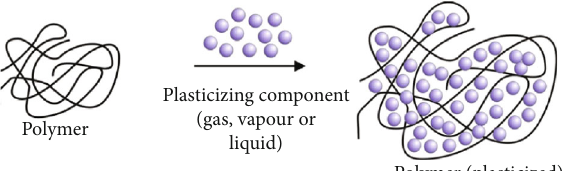
Figure 1: Plasticization phenomenon